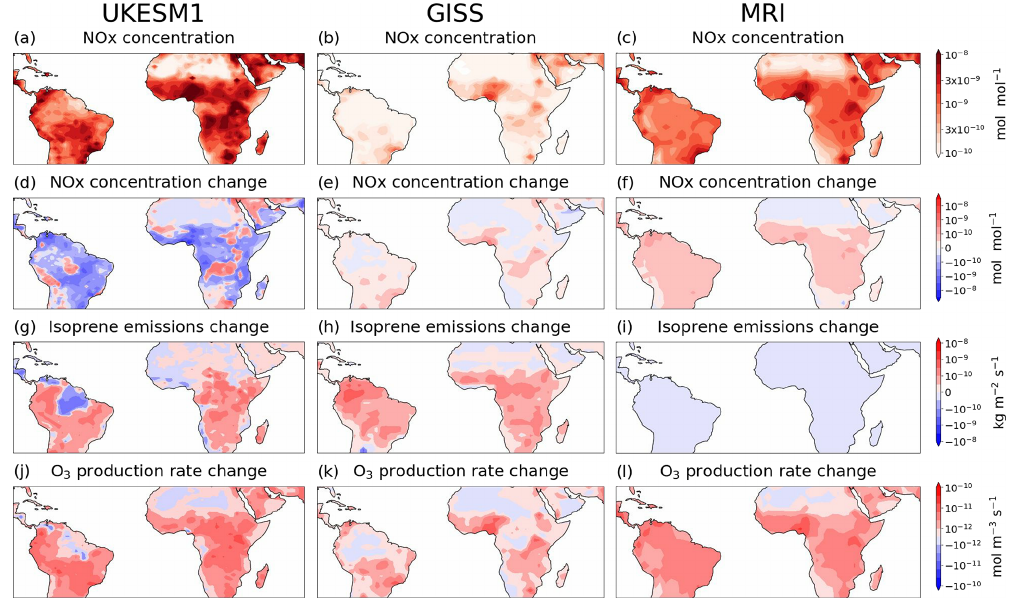
Figure 6. (a–c) Surface NO x concentrations in the absence of climate change and the average change due to climate change in (d–f) NO x concentration, (g–i) isoprene emission rate and (j–l) O 3 production rate for the period 2090–2100 for (column 1) UKESM1, (column 2) GISS and (column 3)